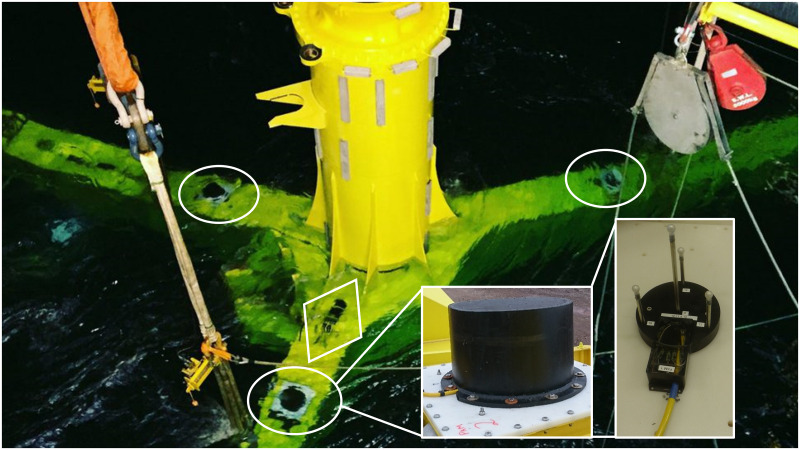
Photograph of three hydrophone clusters installed on a turbine support structure during installation showing the locations of the three hydrophone clusters (circled) and acquisition junction box (in diamond).Inset are photographs of a hydrophone cowling and a tetrahedral cluster showing the four hydrophones on their supports and the box containing potted preamplifiers (photo SIMEC Atlantis Energy).